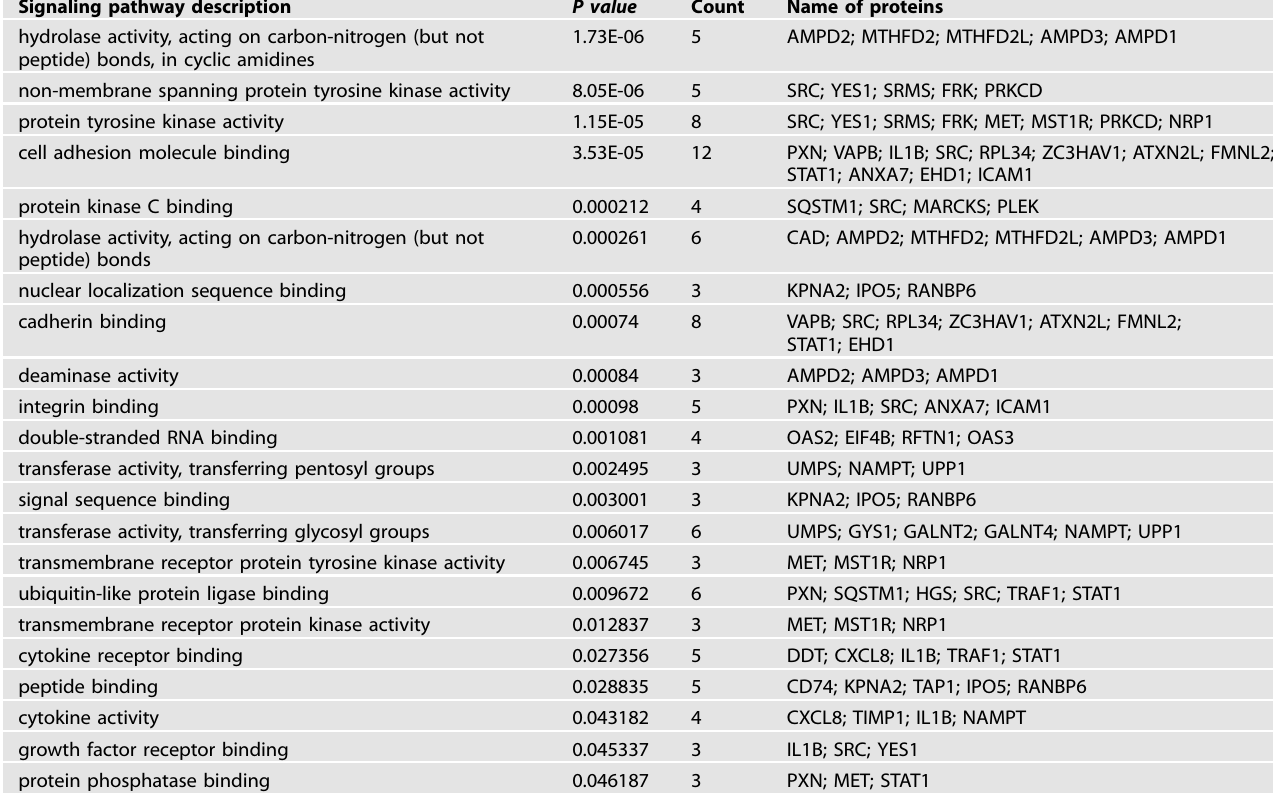
Table 2. Proteins Signi fi cantly up regulated in PA-MSHA treated THP-1cells by proteomics analysis. Signaling pathway description